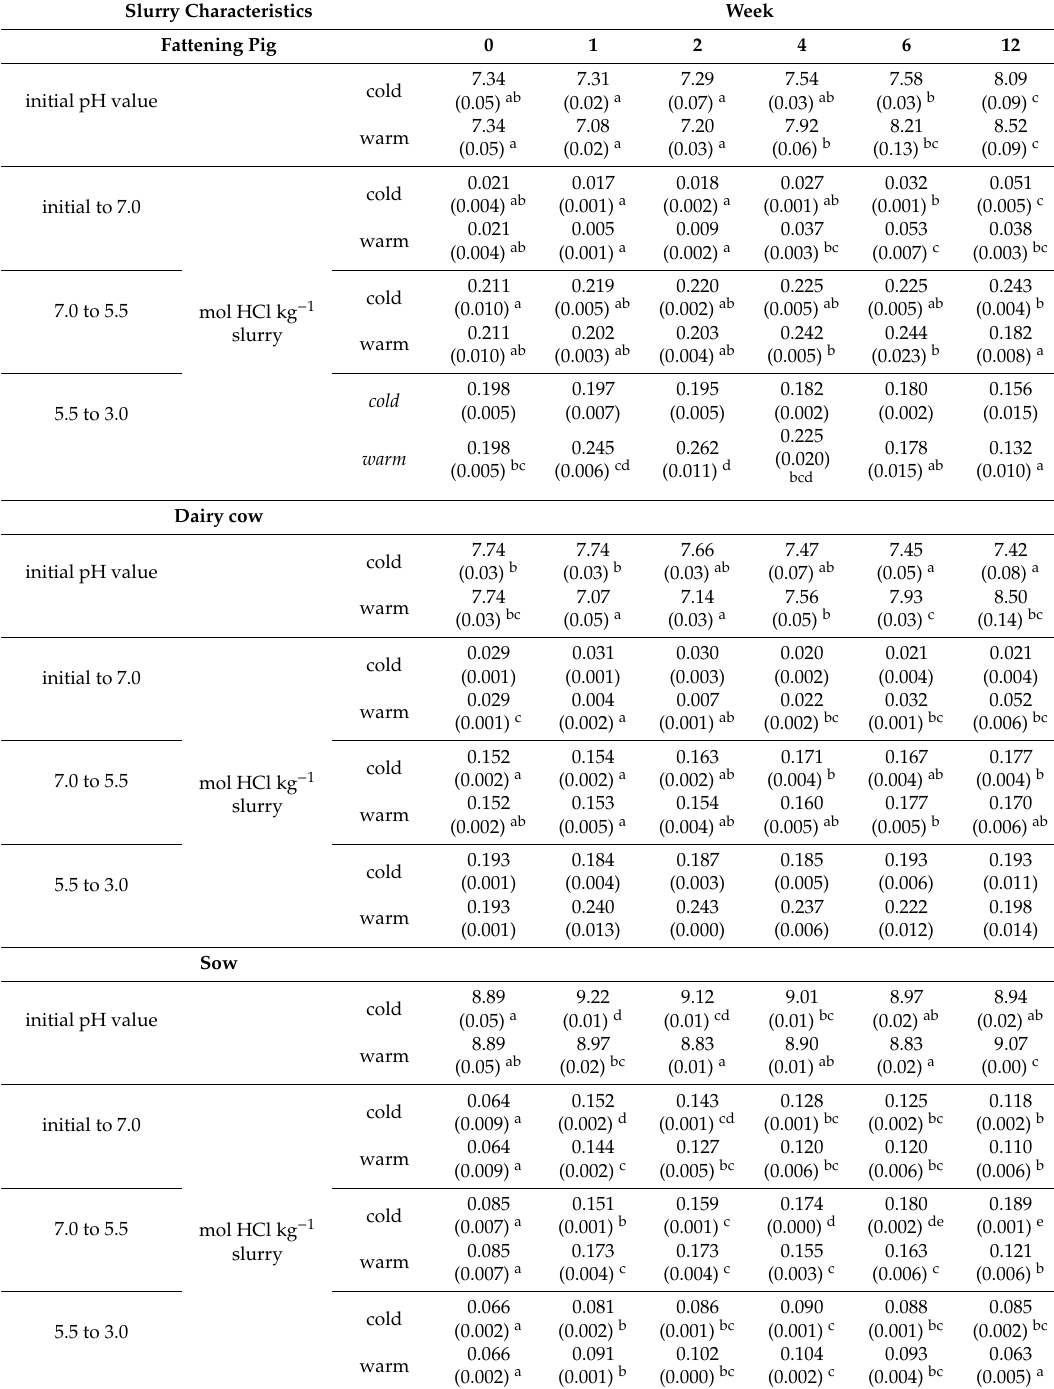
Table A2. Initial pH value of fattening pig, dairy cow and sow slurry as well as amount of acid under cold (4.7 ± 1.1 ◦ C) and warm (23.6 ± 2.1 ◦ C) storage conditions in the pH range initial pH value to 7.0, 7.0 to 5.5 and 5.5 to 3.0 over storage period of 12 weeks (means (SEM)), same letters within rows